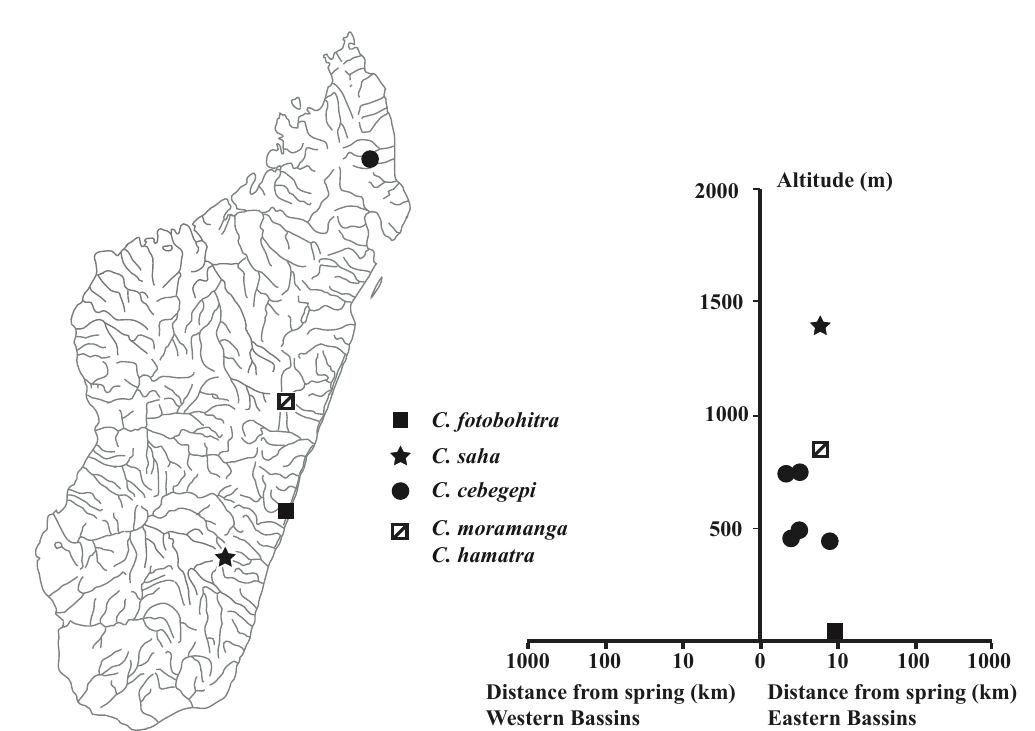
Fig. 17. Chimarra fotobohitra sp. nov., Chimarra saha sp. nov., Chimarra hamatra sp. nov., Chimarra moramanga sp. nov. and Chimarra cebegepi sp. nov., schematic distribution map and ecological profile of the capture sites in Madagascar.